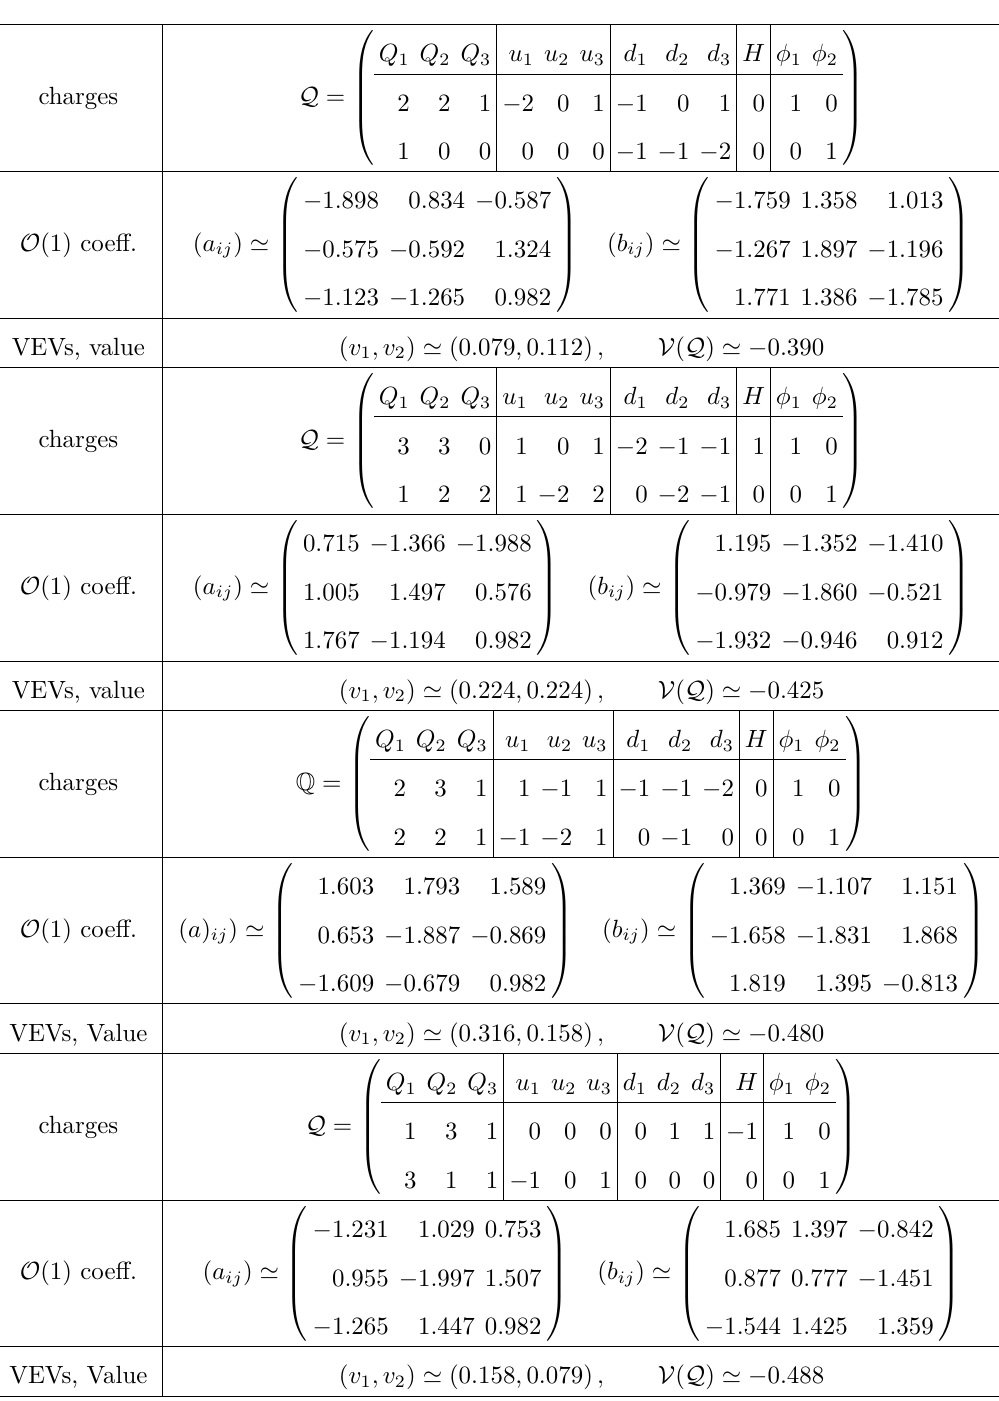
Table 3. Models with high intrinsic value for two U (1)